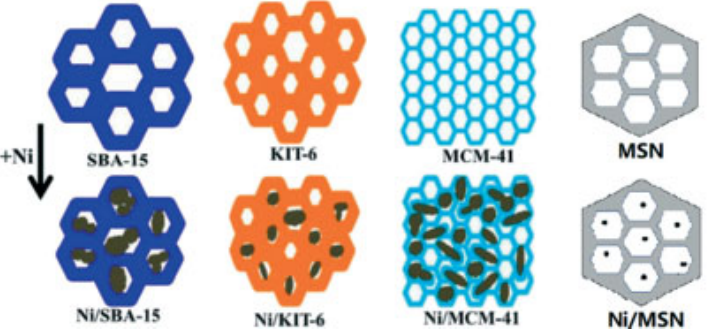
Figure 17. Confinement of active metal sites in mesoporous materials. Adapted from Ref. [224].